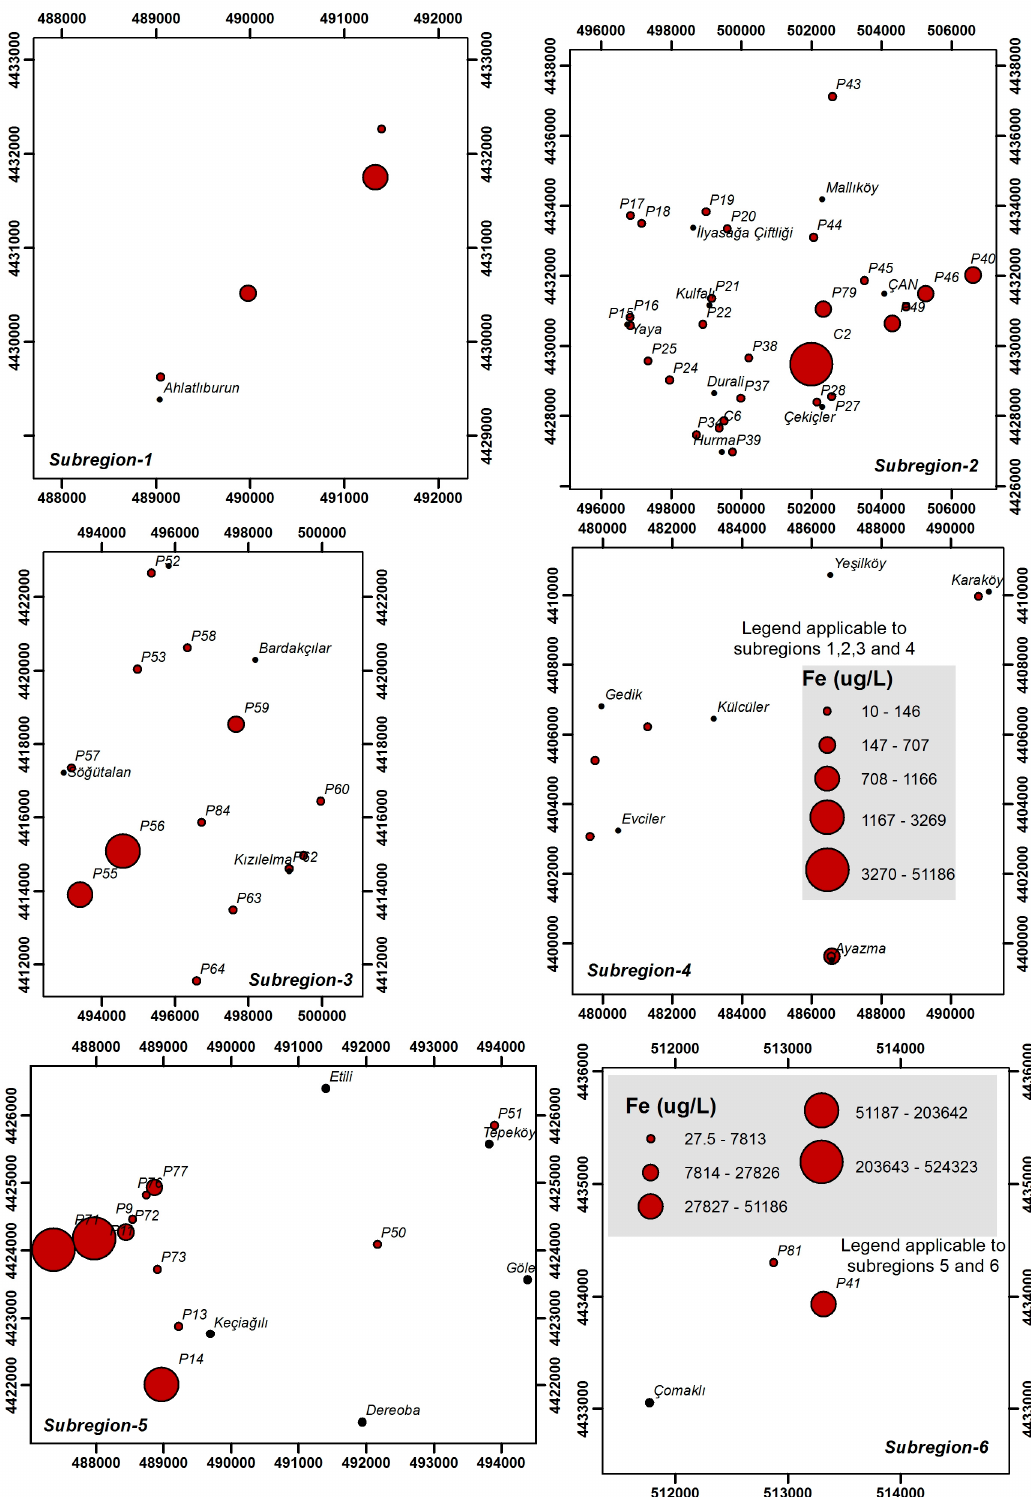
Figure 9. Spatial distribution of iron.